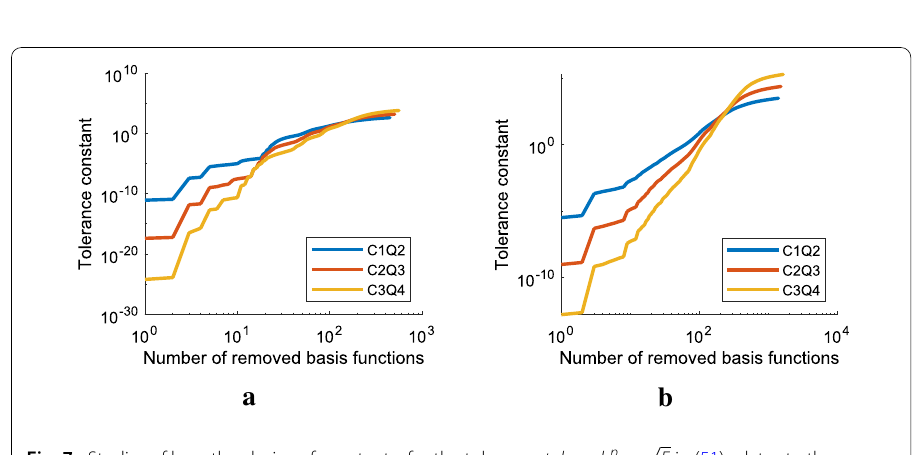
Fig. 7 Studies of how the choice of constant c for the tolerance tol = ch p × number of removed basis functions. The set-up here is the same as in Fig. 6. a a h = 0 . 2. b h = 0 .